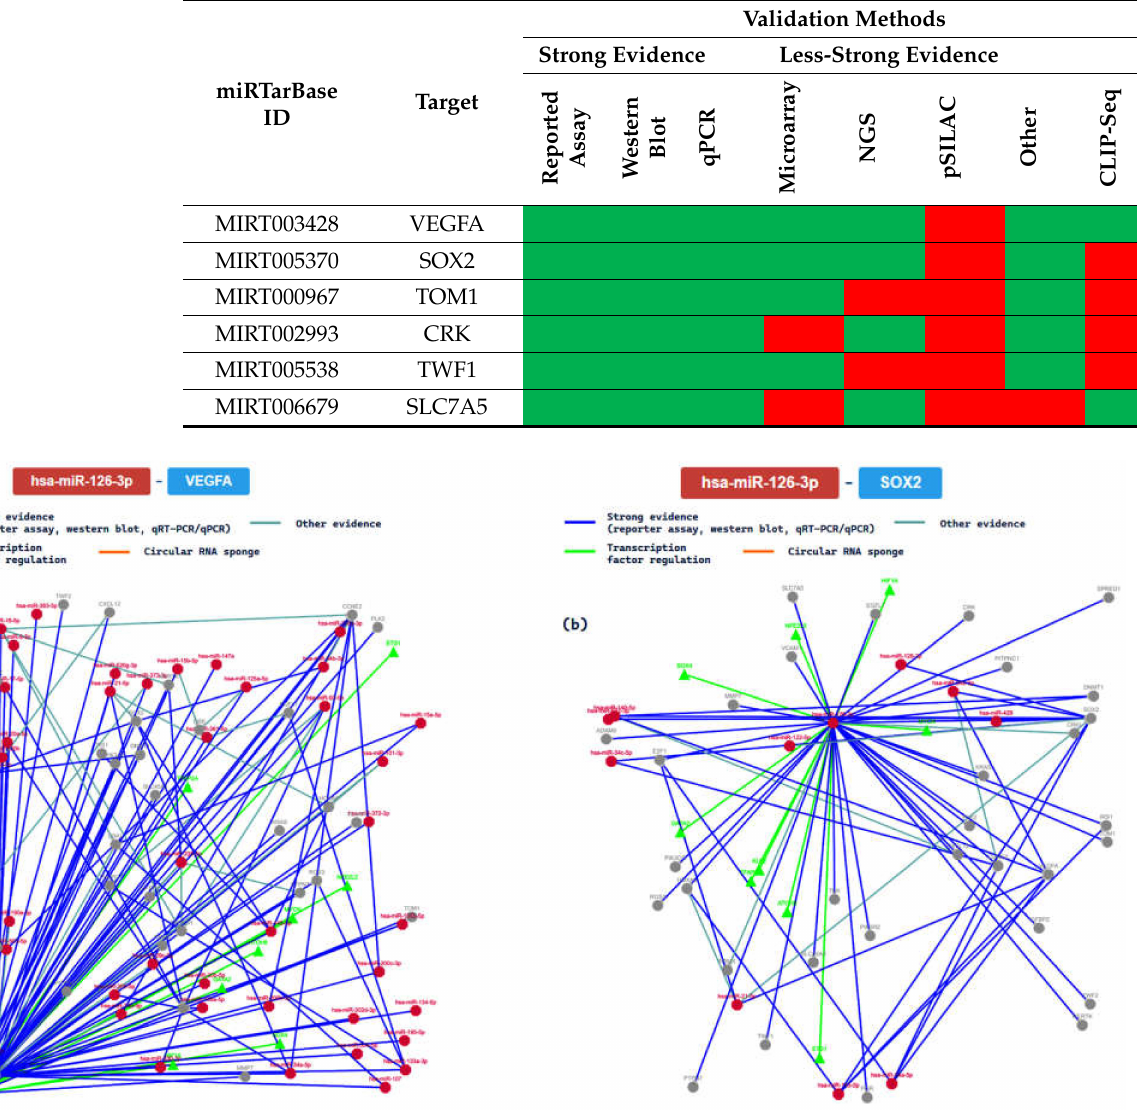
Figure 9. The regulatory network of has-miR-126 and the VEGFA gene ( a ); ( b ) the regulatory network of interaction between the tested miRNA and the SOX2